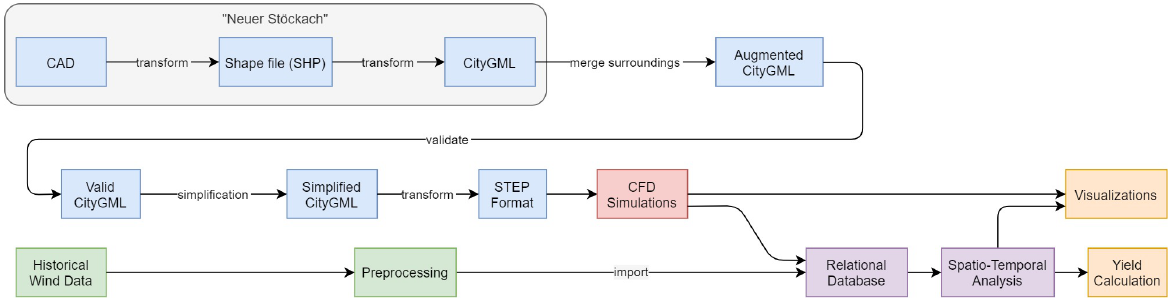
Figure 2. Overall workflow.